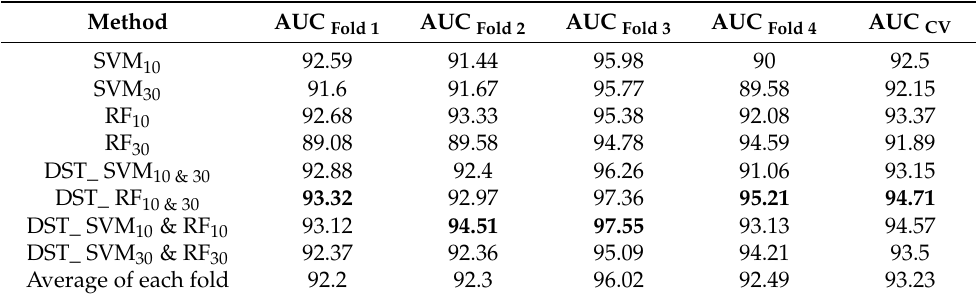
Table 4. The accuracy results for each fold of the applied cross-validation (CV) in percent. The obtained highest accuracy is bolded for each